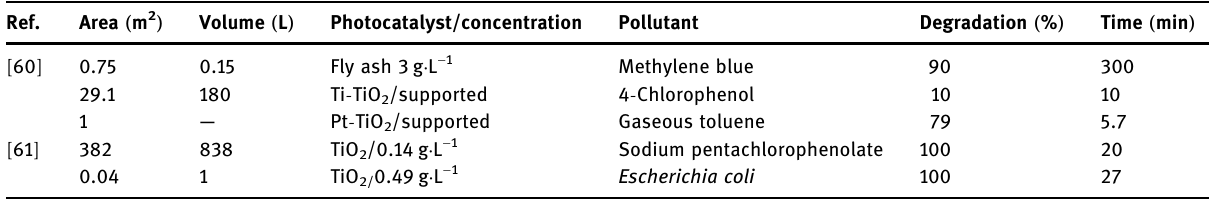
Table 1: Photocatalysis systems with the parabolic collector as a solar concentrator